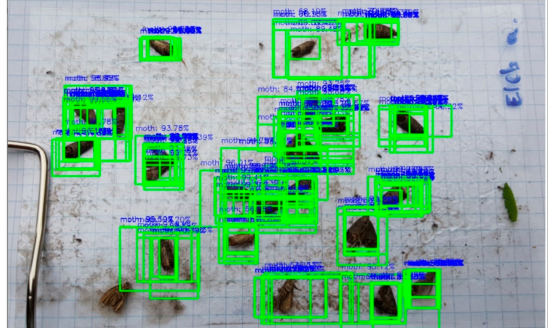
Figure 8. Moth candidate regions where the classifier’s probability value >